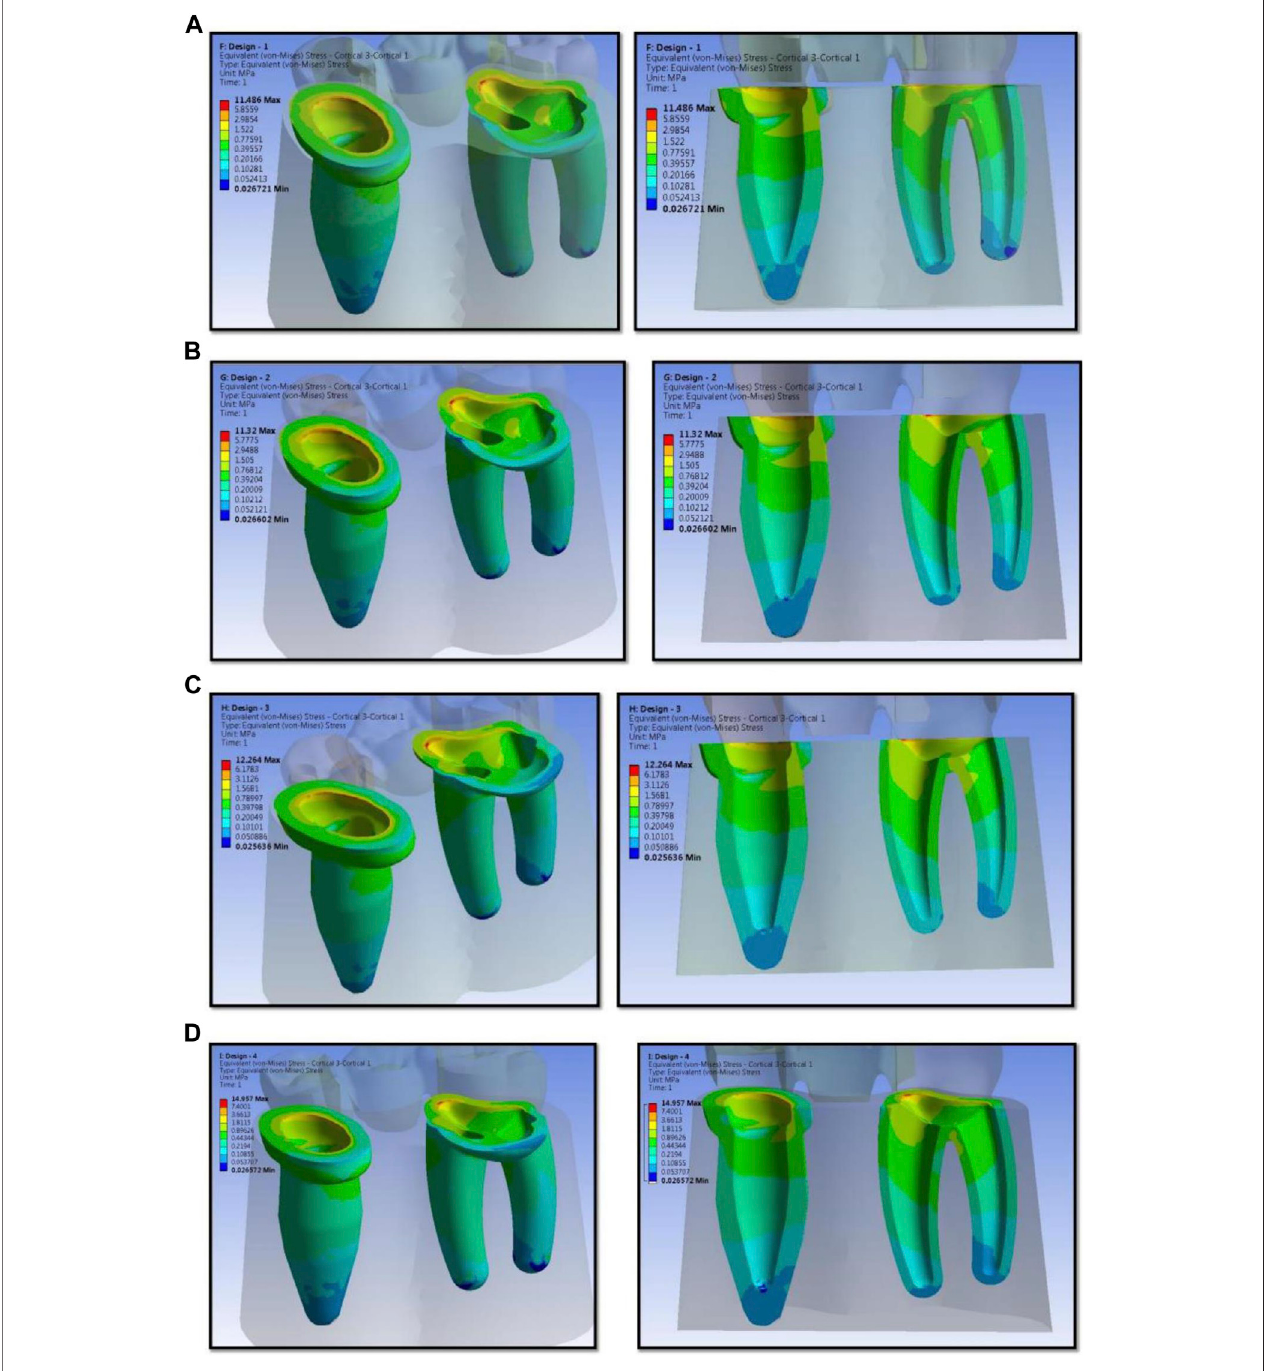
FIGURE 6 | Stress distribution on the different designs of resin-bonded fi xed dental prosthesis on cortical bone for design 1 (A) , design 2 (B) , design 3 (C) , and design 4 (D) used in fi nite element analysis.